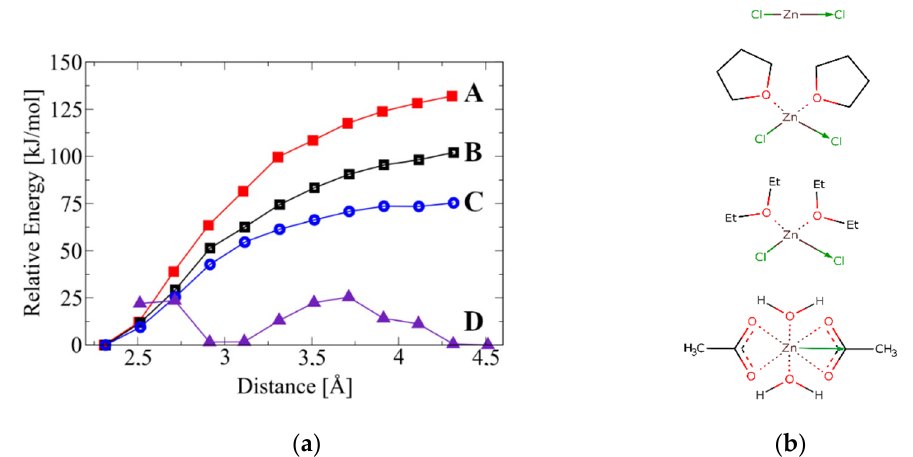
Figure 1. Bond dissociation energy: ( a ) Changes in the relative energy of the metal salts, with respect